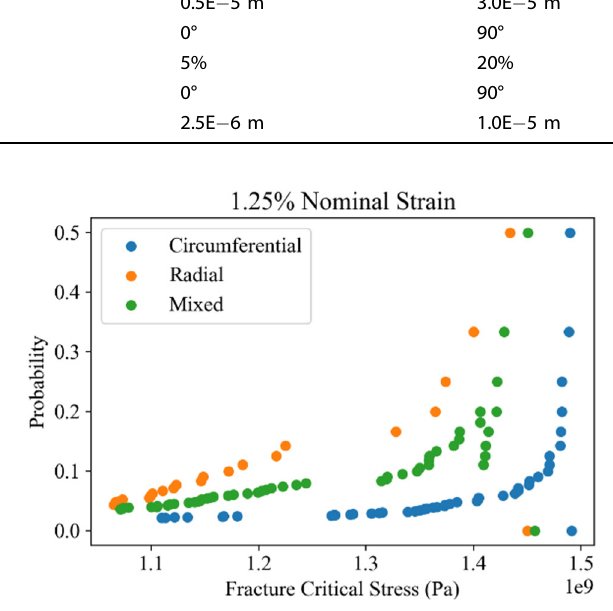
Fig. 4 Bayesian crack probability analysis for 1.25% nominal strain.